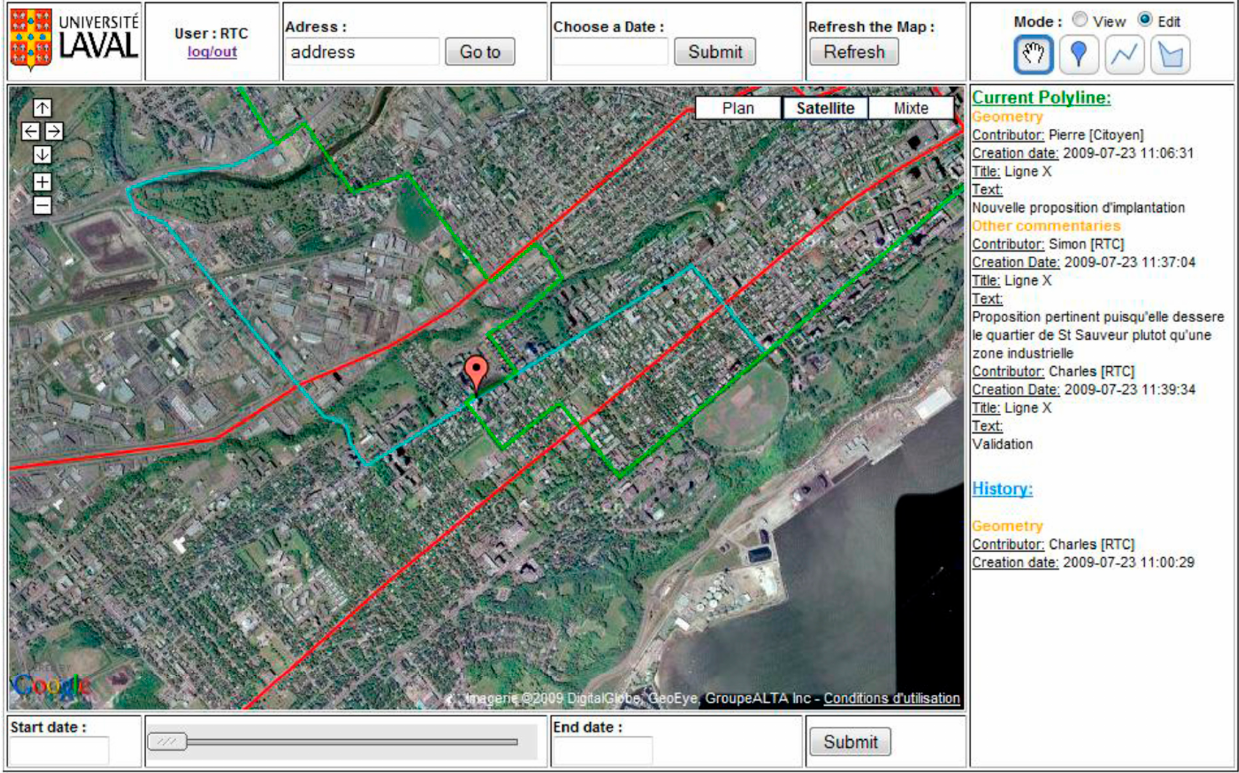
Figure 4. Cartographic interface of the first WikiGIS prototype.